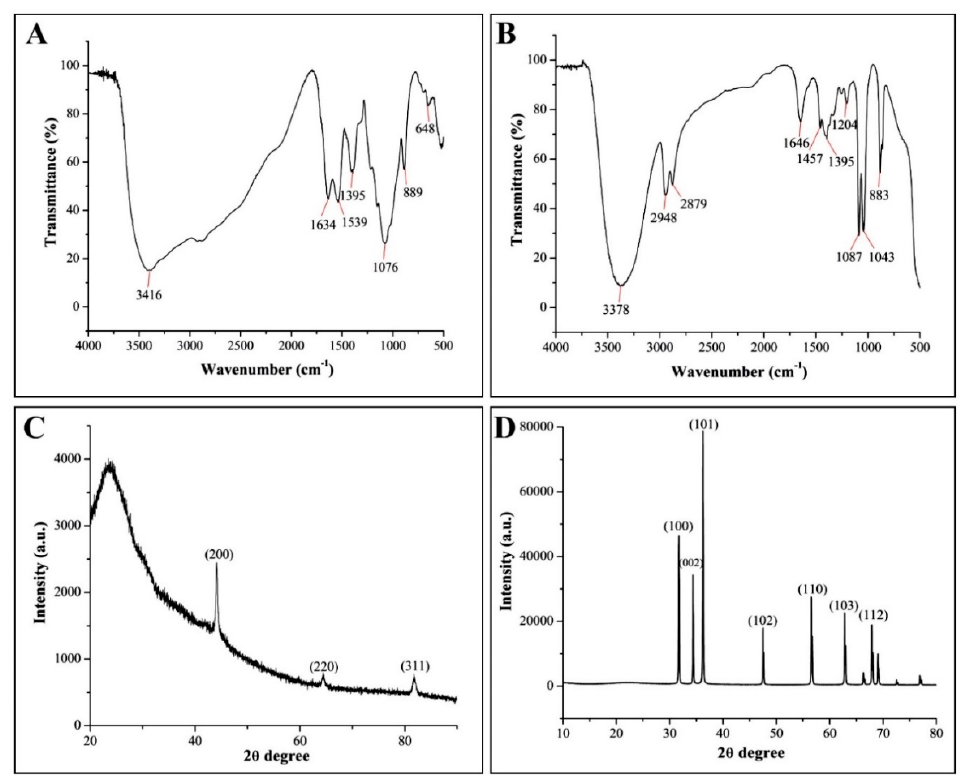
Figure 4. Fourier-transform infrared spectrum of ( A ) CSNPs and ( B ) ZnONPs. X-Rays di ff raction patterns of ( C ) CSNPs and ( D )